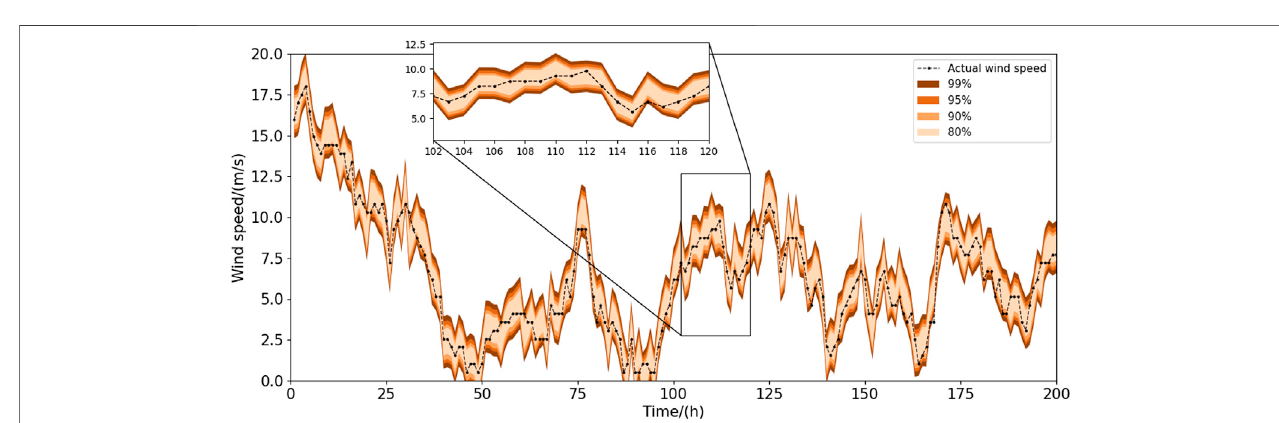
FIGURE 12 | Interval prediction of different con fi dence within spring.